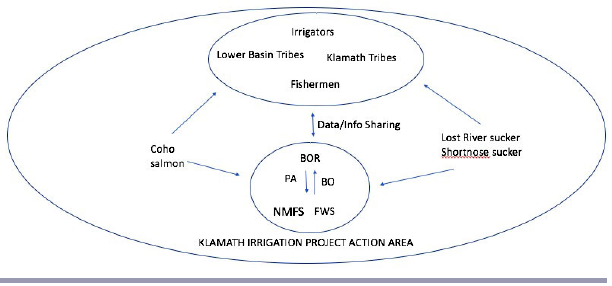
Fig. 3 . Section 7 Consultation Process for 2013 Joint Biological Opinion: Integrated Approach. Stakeholders collaborated on a water sharing plan using hydrologic modeling. Stakeholders shared data and information with Bureau of Reclamation (BOR) in development of proposed action (PA). BOR worked with National Marine Fisheries Service (NMFS) and U.S. Fish and Wildlife Service (FWS) to develop the PA in a coordinated way that took into account needs of fish. NMFS and